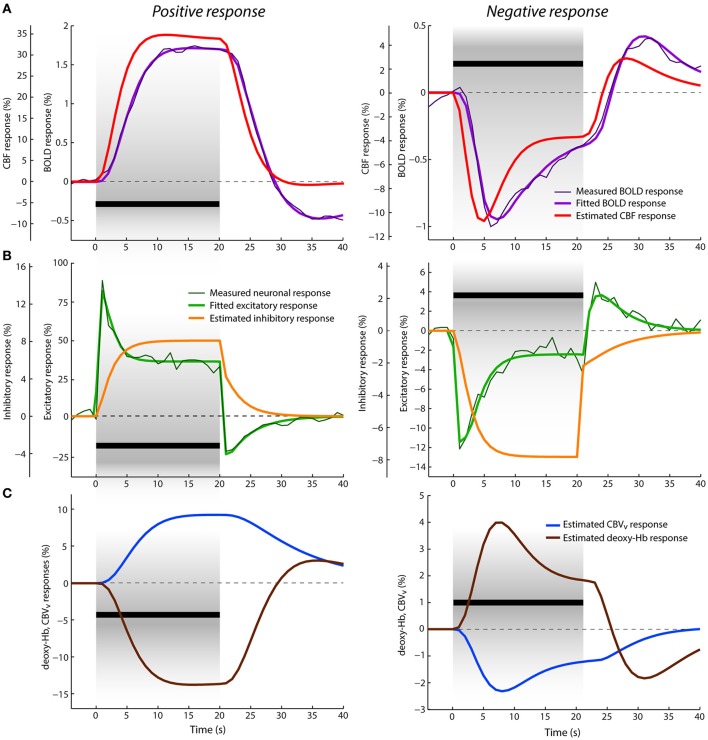
Data and results depiction of experiment III. This figure and its sections follow the same plotting format as Figure 2. The average positive (left) and negative (right) neuronal and BOLD responses are replotted versions of the data reported in Figures 1D, 2A of Shmuel et al. (2006). (A) The estimated CBF and fitted BOLD (and average measured BOLD) responses. (B) The average measured neuronal responses are depicted with dark thin green lines overlaid with fitted excitatory responses displayed with thick green lines. (C) The estimated venous CBV and deoxyhemoglobin content responses in percent signal change.